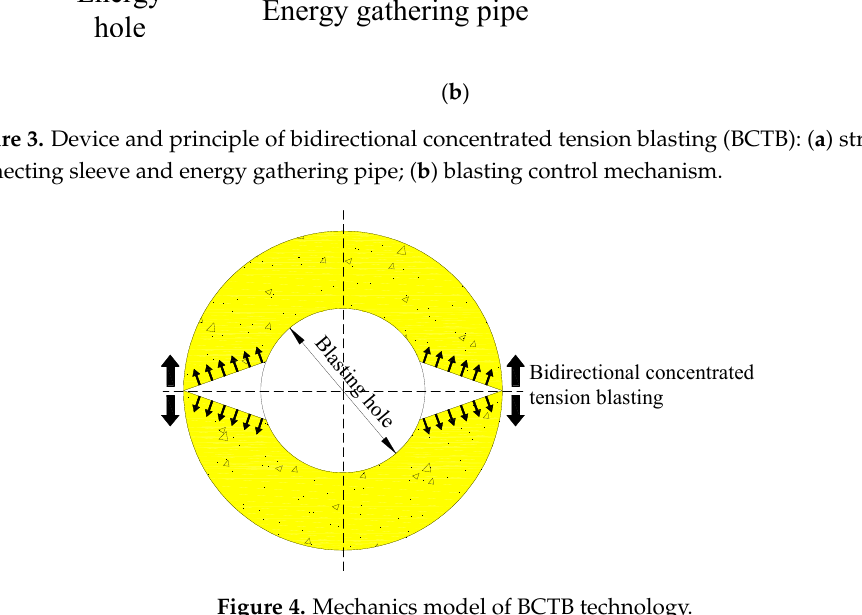
Figure 4. Mechanics model of BCTB technology.